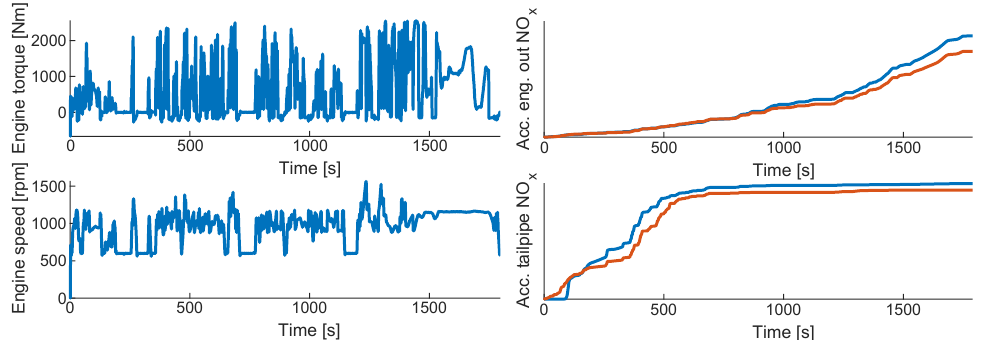
Figure 3. Validation of the model using the WHTC. Inputs are shown on the left and outputs are on the right. The blue lines are data from experiments and the red lines are simulated